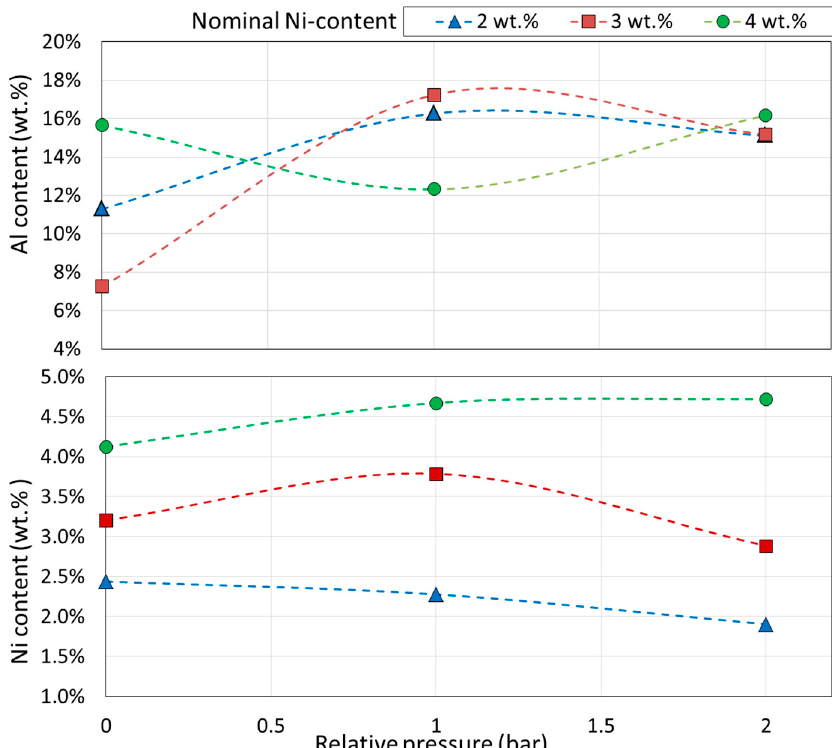
Figure 2. Elemental content of Al and Ni determined via EDS analysis in specimens fabricated at varying relative pressures. The dotted lines are added for visual clarity.